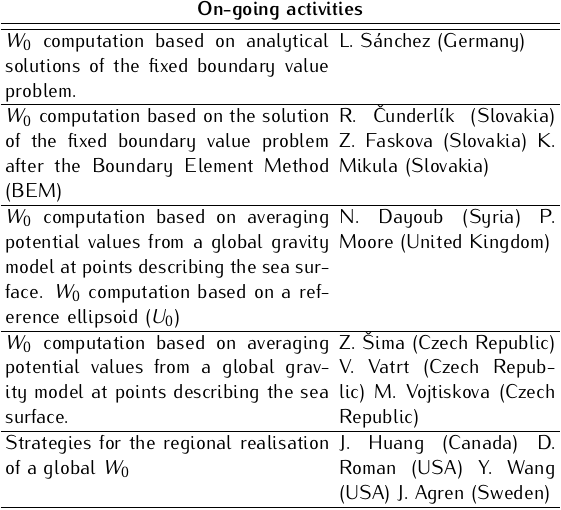
Table 4. On-going activities of the working group on Vertical Datum Standardisation. On-going activities W 0 computation based on analytical solutions of the fixed boundary value